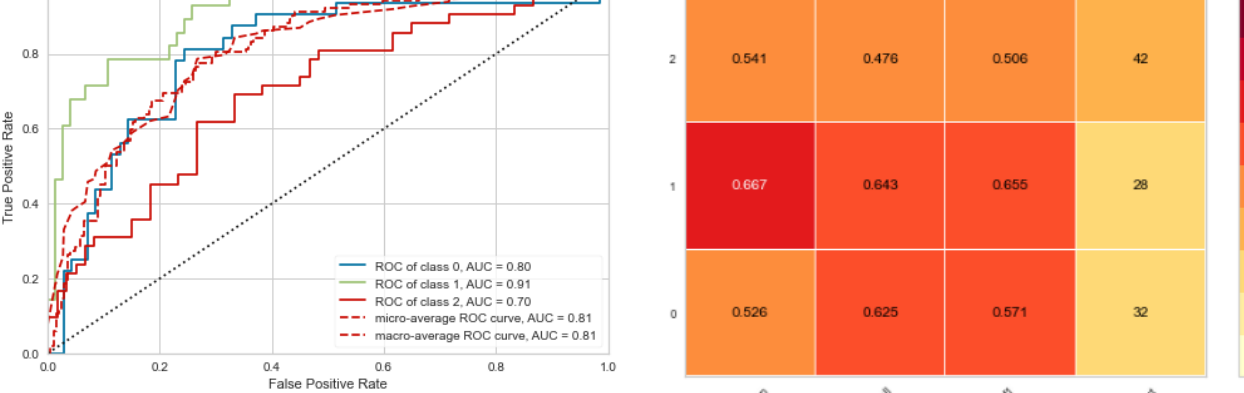
Fig. 8. ROC curve for MLP classifier.